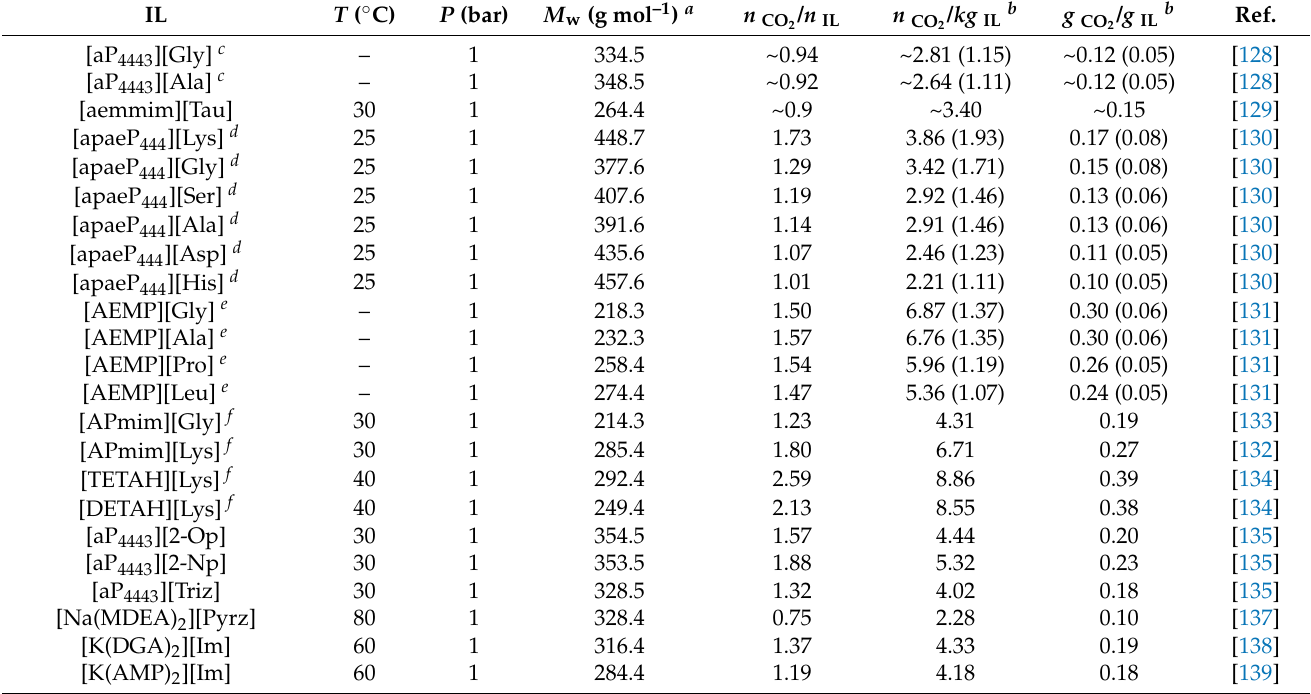
Table 4. Typical cation-anion dual-functionalized ILs for CO 2